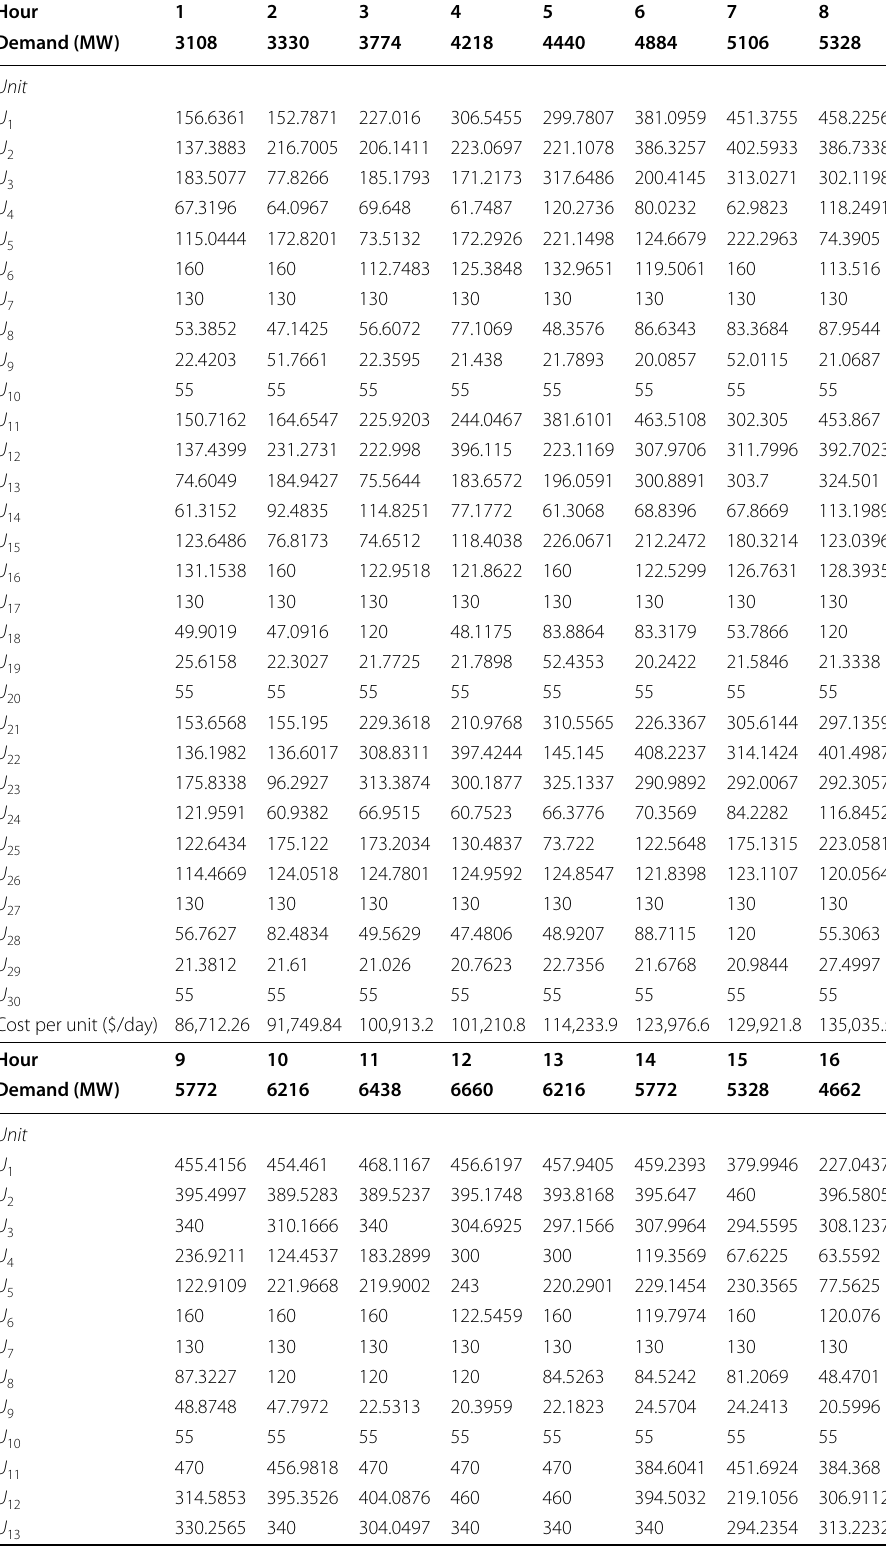
Table 15 Simulation results for optimal 24-h cost and loss of 30-unit test